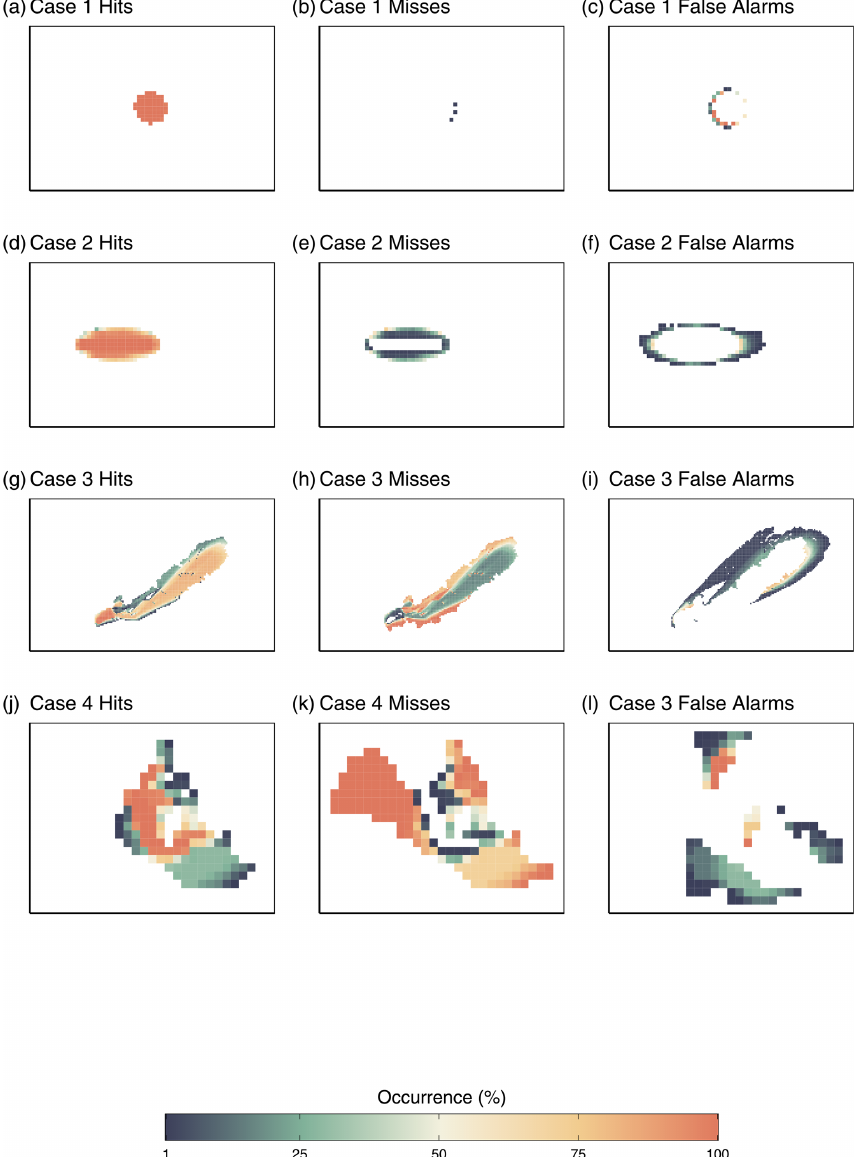
Figure 6. Individual FoM components from each simulation, stacked as ensemble maps. Cell value represents how many times a cell was part of a given component in the ensemble, in other words, the percent occurrence in that category. In this case count and percent are equivalent, given that an ensemble consists of 100